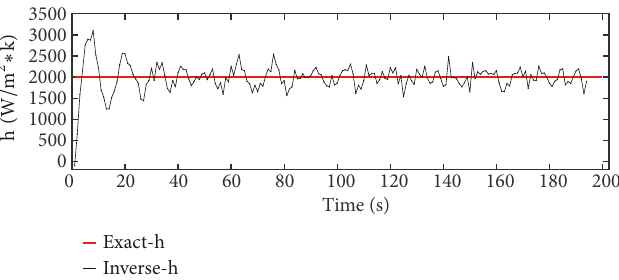
Figure 15: The heat transfer coefficient of the measuring point at the distance from the boundary 𝑙 = 0.001𝑚 .